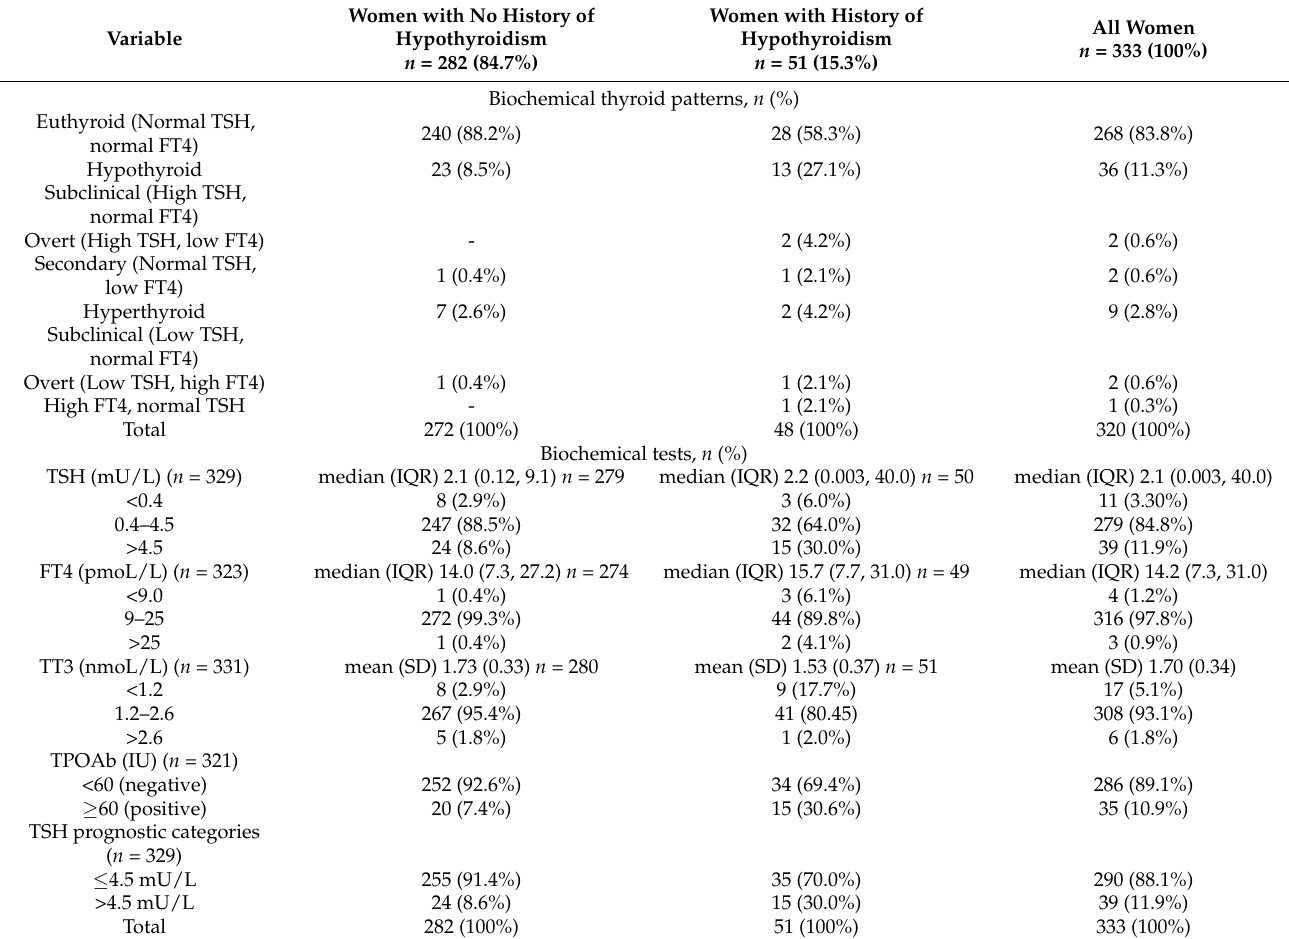
Table 2. Clinical and biochemical thyroid function at